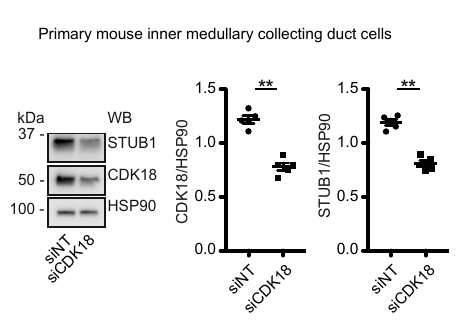
Figure 4. CDK18 regulates STUB1 to control AQP2 ubiquitination, abundance and localisation. ( A ) MCD4 cells were transfected with control non-targeting (siNT) or CDK18 siRNA, lysed and AQP2 was immunoprecipitated (IP). As a control, unrelated IgG was used (IgG). AQP2 and co-immunoprecipitated ubiquitin (Ubi) were detected by Western blotting (WB). Shown are a representative result from n = 4 independent experiments including the input samples where HSP90